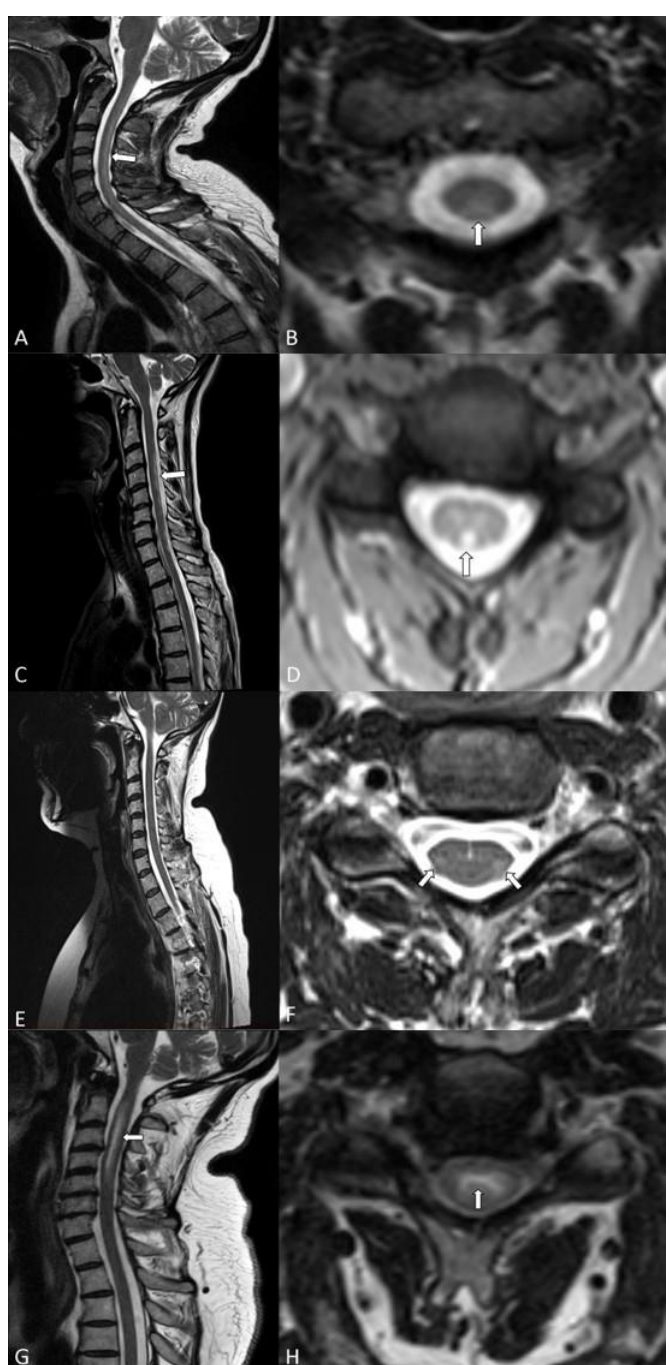
Figure 2. Cervical spinal cord MRI of all patients, with sagittal (left) and axial (right) T2-weighted sequences. ( A , B ) Patient 1: White arrow indicates a right-sided homogeneous T2-hyperintense lesion in the posterior columns. ( C , D ) Patient 2: White arrow indicates a T2-hyperintense longitudinally extensive spinal cord lesion in the posterior columns. ( E , F ) Patient 3: White arrows indicate a long segment T2 lesion of the lateral pyramidal tracts and lateral spinothalamic tracts. ( G , H ). Patient 4: White arrow indicates a long segment T2-hyperintense lesion mainly involving the central grey matter.